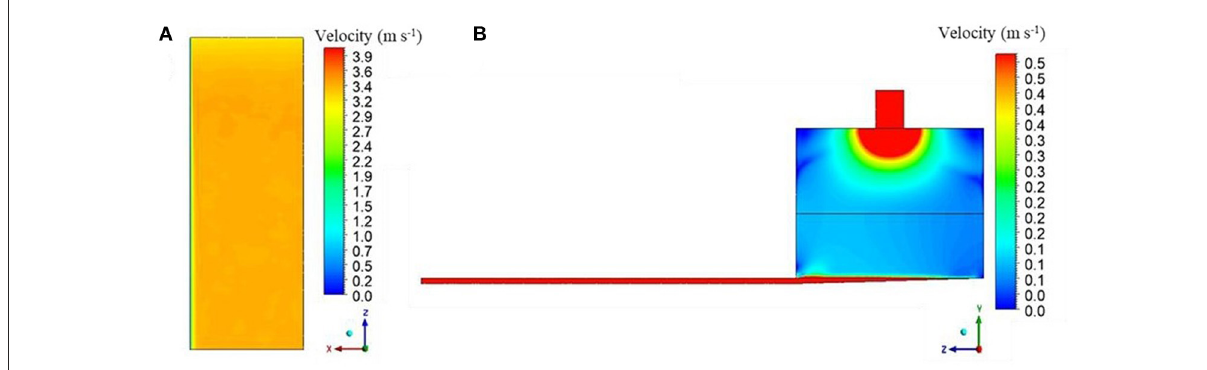
FIGURE4 Contours of the predicted velocity distribution in the optimized design of the loaded solar dryer: (A) a horizontal profile through the middle of the collector from inlet to plenum, (B) a vertical profile on the symmetry plane of the dryer.